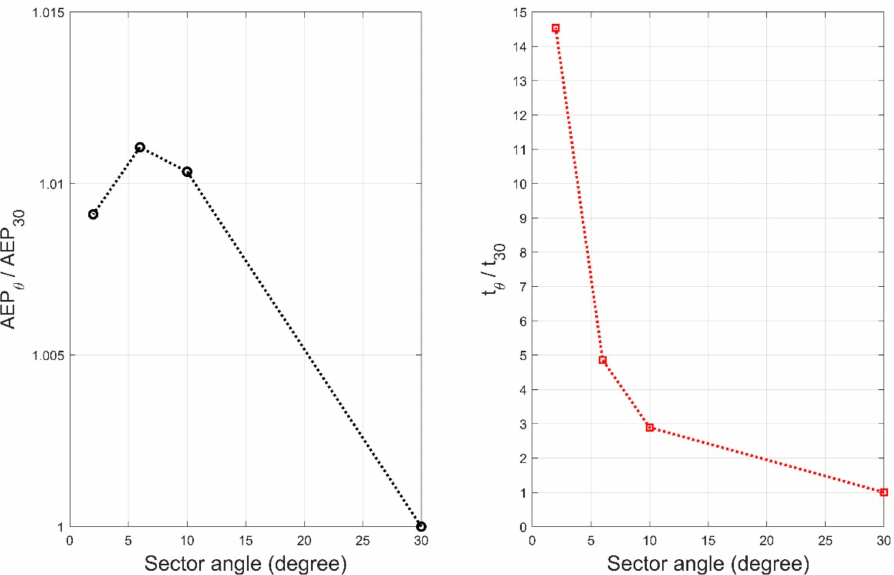
Figure 6. E ff ect of sector angle on the estimated AEP and execution time, t , normalized with respect to the corresponding values for 30 ◦